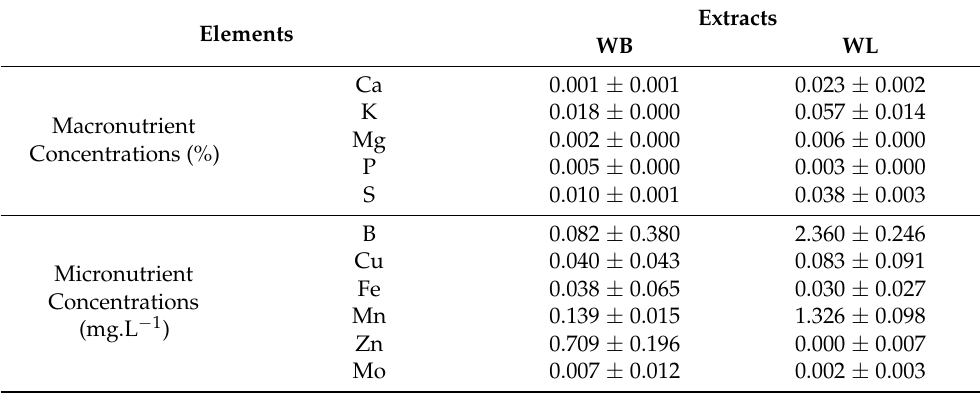
Table 7. The mineral element concentration of the willow extracts.